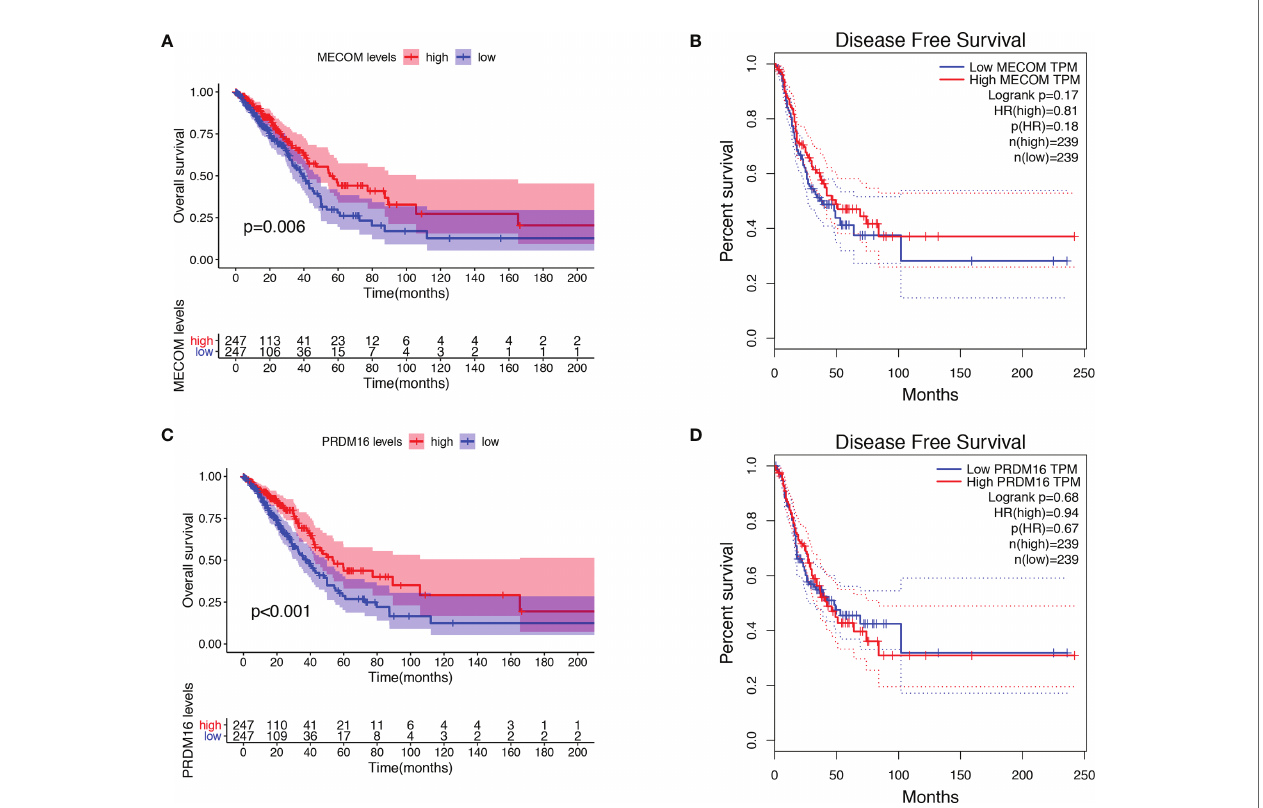
FIGURE 4 | Correlation between the expression of MECOM and PRDM16 and prognosis in LUAD. (A, B) Correlation between MECOM, OS (A) , and DFS (B) in LUAD. (C, D) Correlation between PRDM16, OS (C) , and DFS (D) in LUAD. MECOM, MDS1 and EVI1 complex locus, also called PRDM3; PRDM16, PR domain containing 16, also called MEL1; LUAD, lung